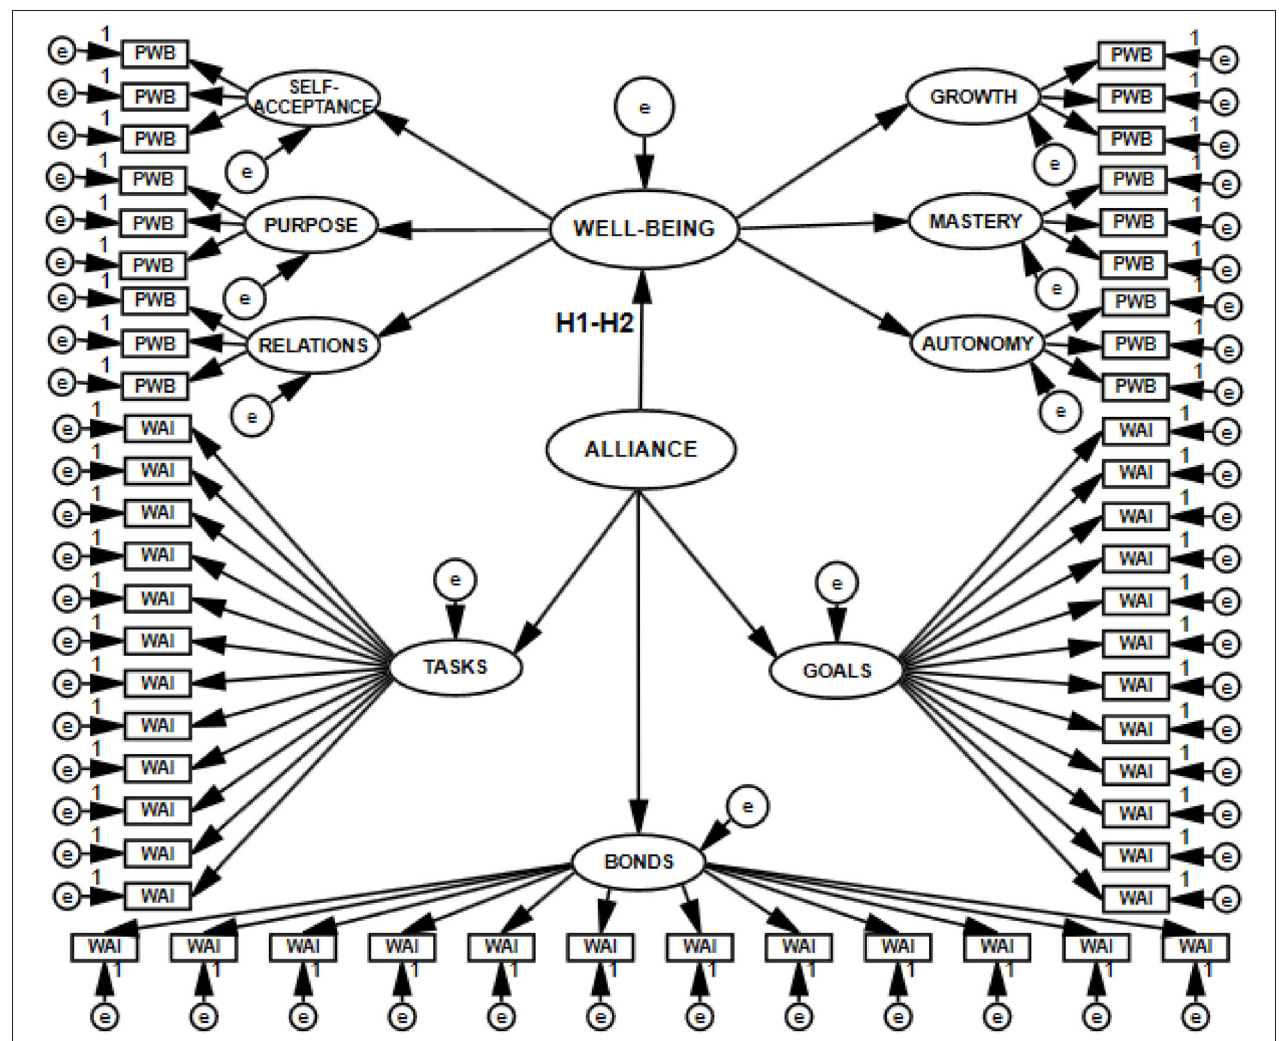
FIGURE 3 | Structural and measurement model with 11 latent variables postulating the direction of relations between the working alliance and psychological well-being, tested with SEM.